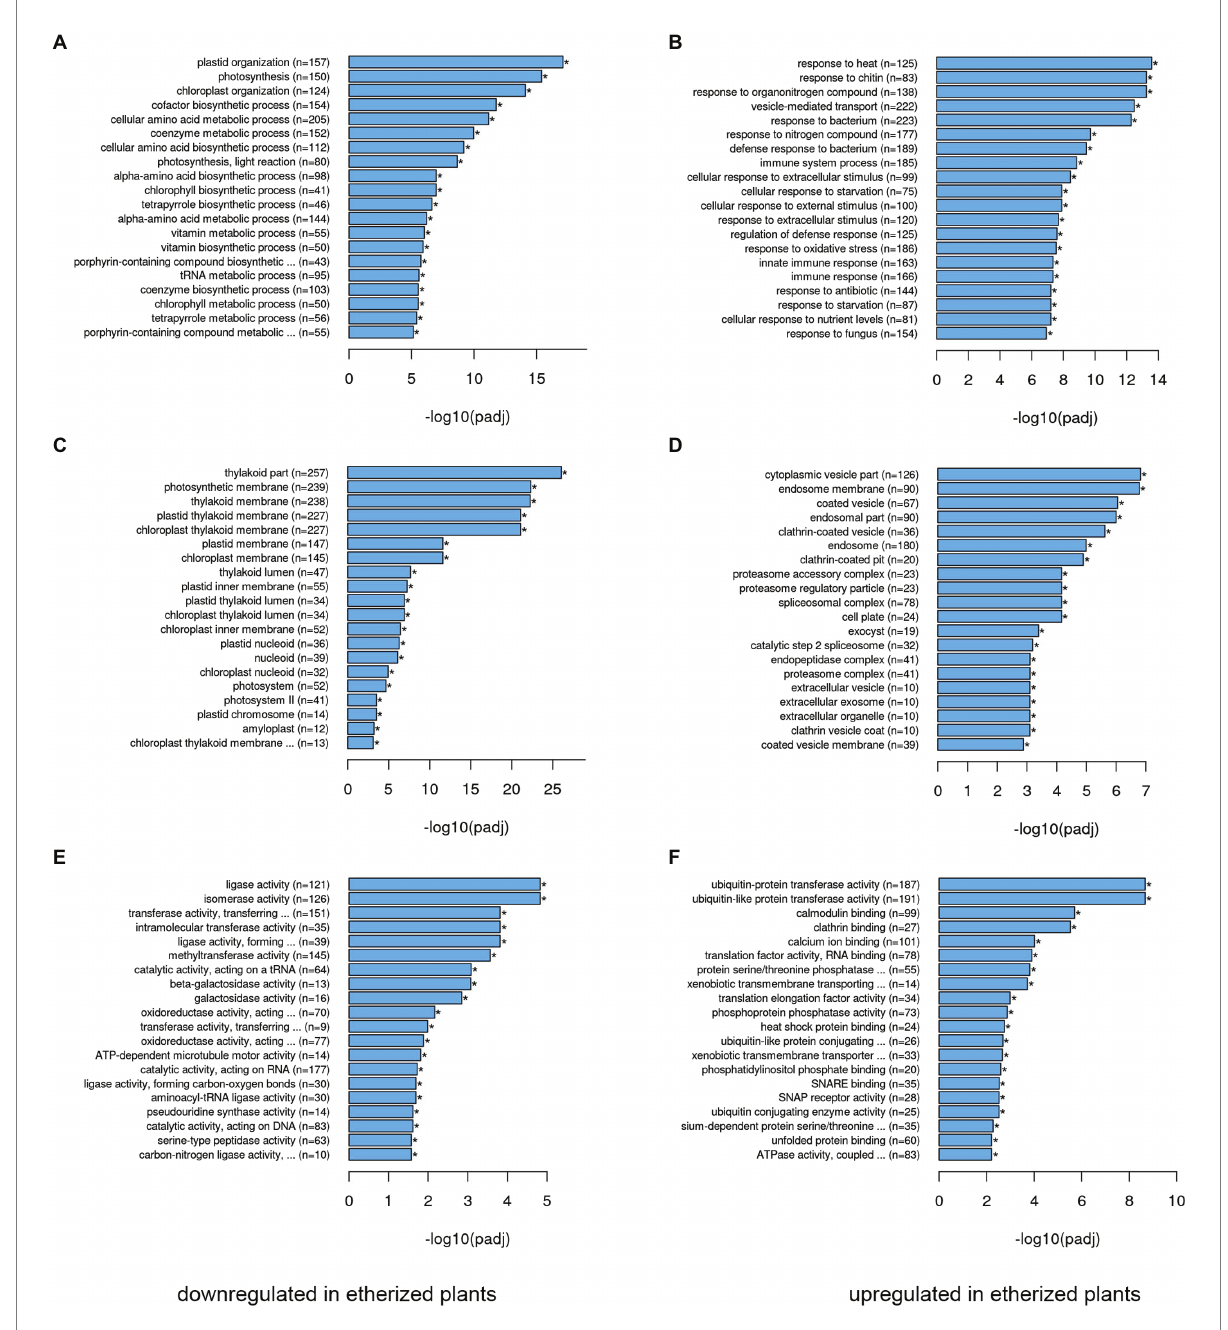
FIGURE 2 Gene ontology (GO) functional analysis of differentially expressed genes (DEGs) in Arabidopsis thaliana . The 20 most significantly ( p < 0.05) enriched downregulated GO terms in biological process (A) , cellular component (C) , and molecular function (E) branches in etherized plants compared to control are presented. The 20 most significantly ( p < 0.05) enriched upregulated GO terms in biological process (B) , cellular component (D) , and molecular function (F) branches in etherized plants compared to control are presented. All the adjusted statistically significant values of the terms were negative 10-base log transformed. Asterisks (*) denote significantly different GO terms at p < 0.05. A complete list of GO terms is available as Supplementary Table